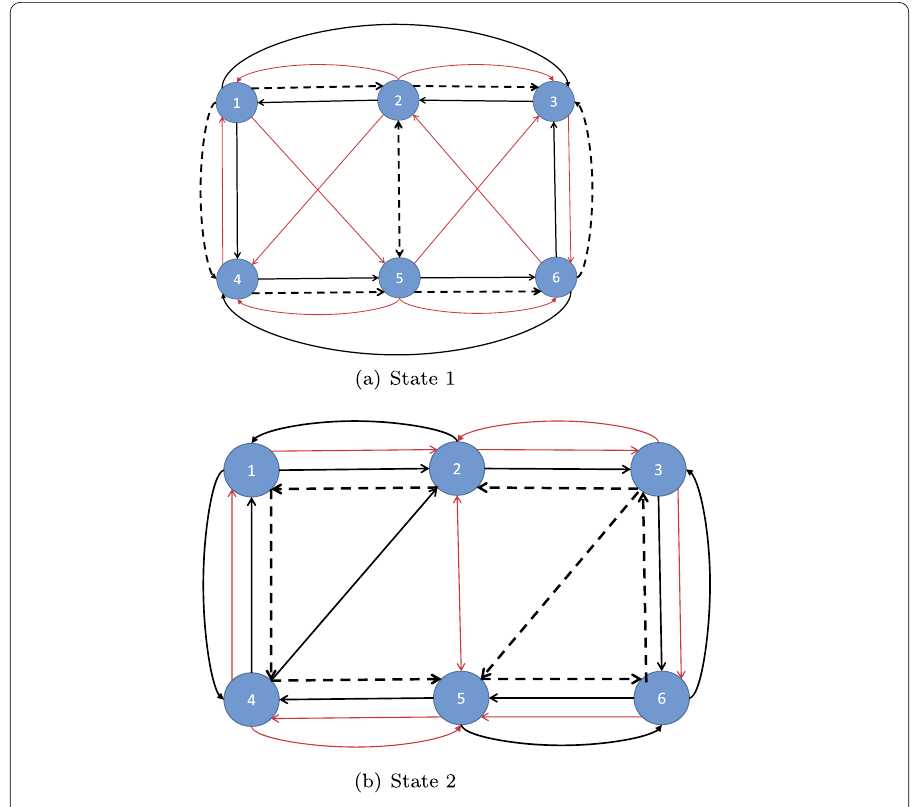
Figure 1 The diagram for a network with six nodes, three different kinds of weights, and two states